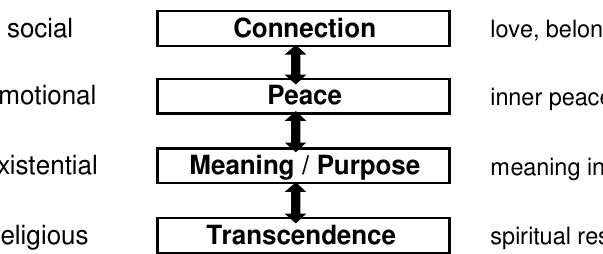
Figure 1. Model of spiritual